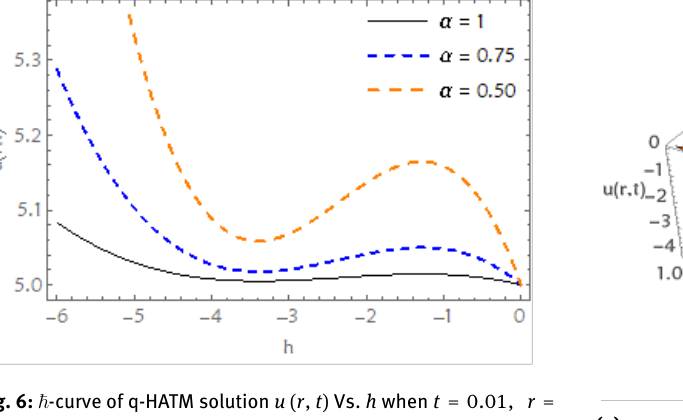
Fig. 6: (cid:126) -curve of q-HATM solution u ( r , t ) Vs. h when t = 0.01, r = 1, n = 3 for Ex. 4.1